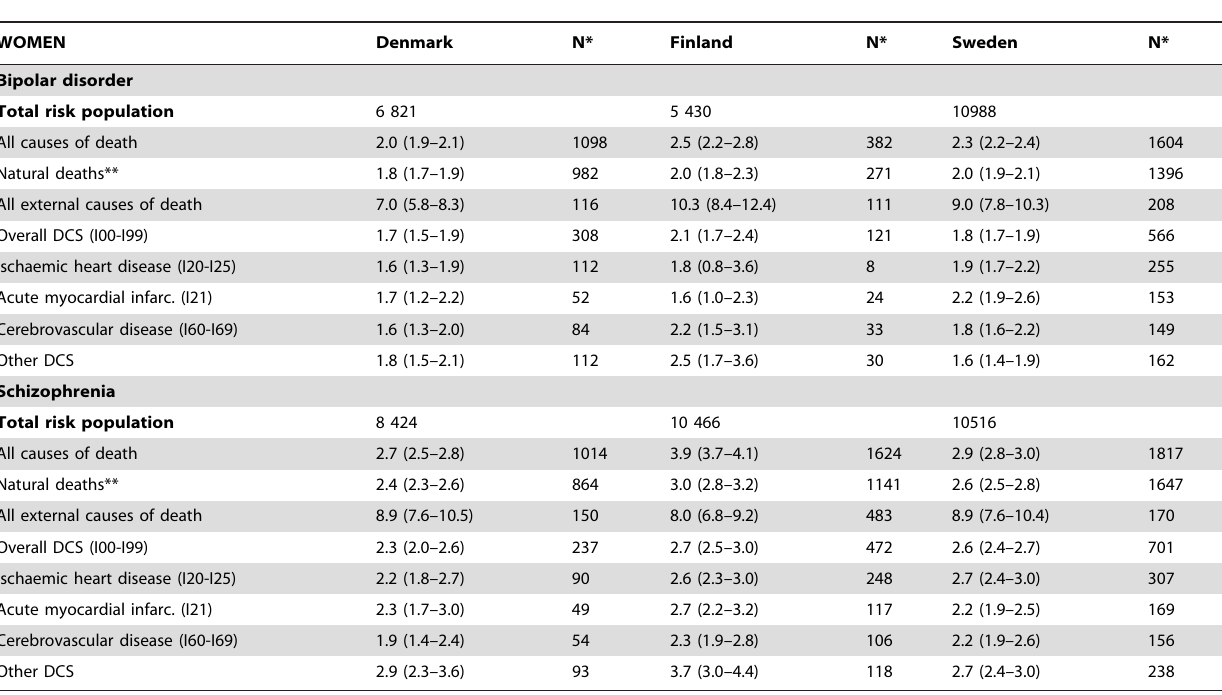
Table 2. Standardized mortality rates (SMR) for overall mortality, natural/unnatural causes and a sub-division of diseases of the circulatory system (DCS; ICD I00-I99) for women with bipolar disorder/schizophrenia compared to the general population in Denmark, Finland, and Sweden with 95% confidence intervals.